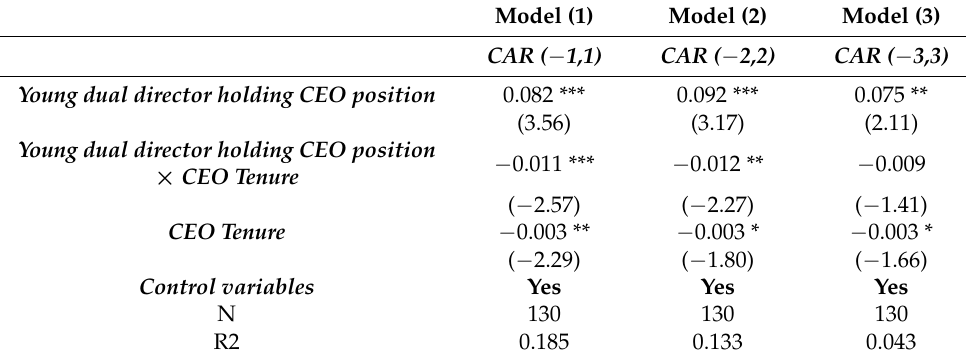
Table 8. Internal labor market and career concerns. This table presents the results of OLS regressions of CAR surrounding the announcement day of the equity carve-out. Young dual director holding CEO position takes a value of 1 for firms with at least 1 young dual director holding the CEO position in the subsidiary firm and 0 otherwise. CEO Tenure is the number of years for which the incumbent CEO of the subsidiary takes the position. See Appendix A Table A1 for the variable definition. The t-statistics are in parentheses. *, **, and *** indicate significance at the 10%, 5%, and 1% levels, respectively.